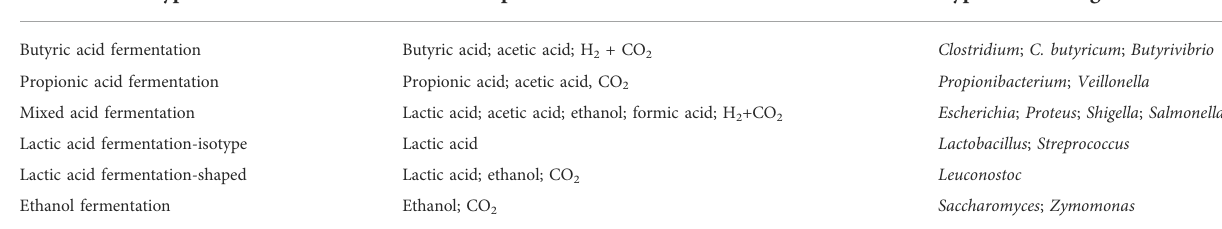
TABLE 2 Main classical types of carbohydrate